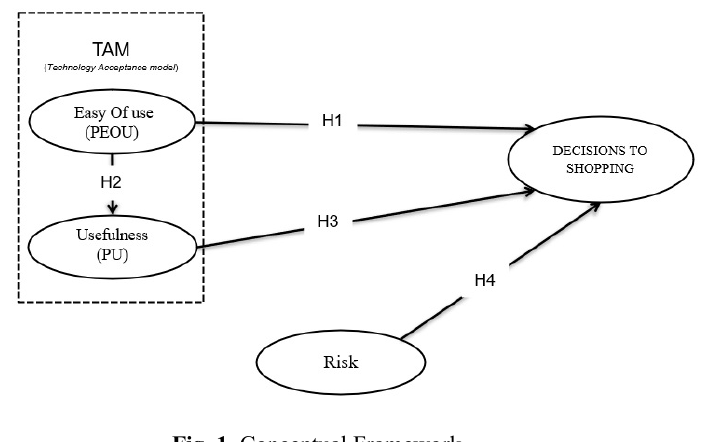
Fig. 1. Conceptual